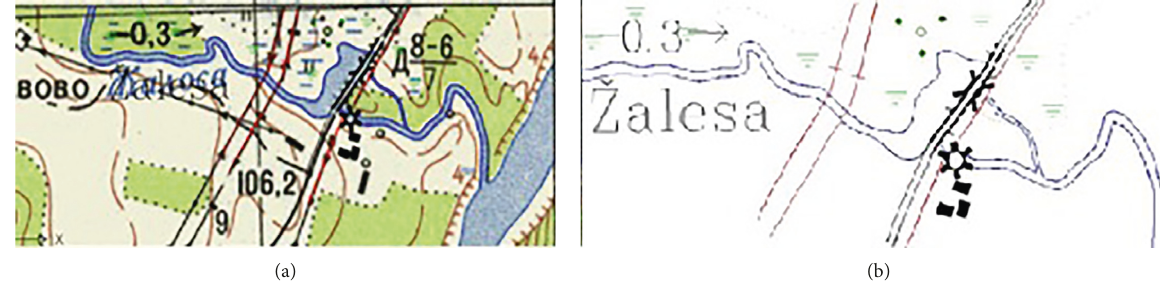
Figure 6: Digitized section of River ˇZalesa is represented in the topographic map of 1966 (source: http://www.geoportal.lt and authors’